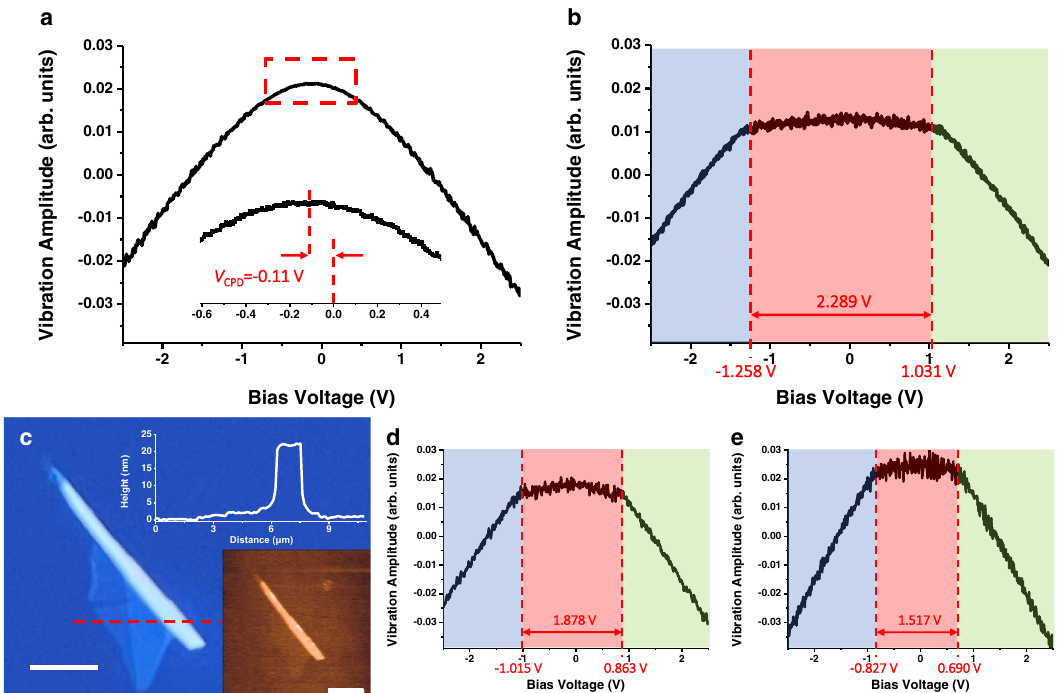
Fig. 2 | LEFM measurement on MoS 2 sample. a The representative vibration amplitude vs. the external bias curves on monolayer MoS 2 under the regular EFM working mode. The inset is the zoom-in of the apex area. The offset of the paraboliccurvefromthezerobiasindicates V CPD .Therepresentativecurvesof vibration amplitude vs. external bias on b monolayer, d bilayer, and e multilayer (thickness ∼ 22nm) MoS 2 with the LEFM working mode. The bias